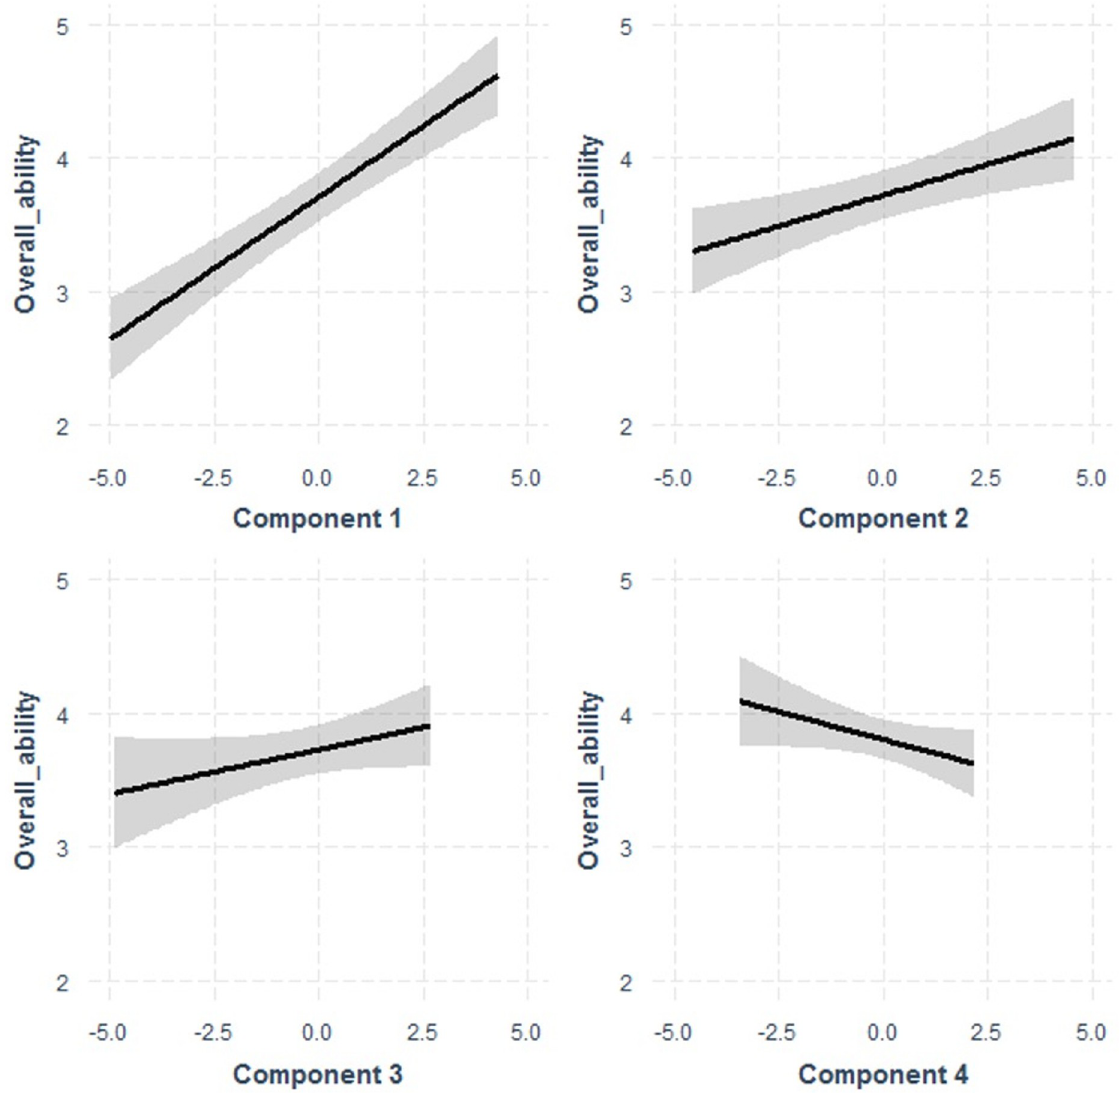
Fig 3. Effect of component on overall ability scores for 210 kelpies as estimated by multivariable mixed model regression. Components 1, 2 and 4 are slopes significantly different from